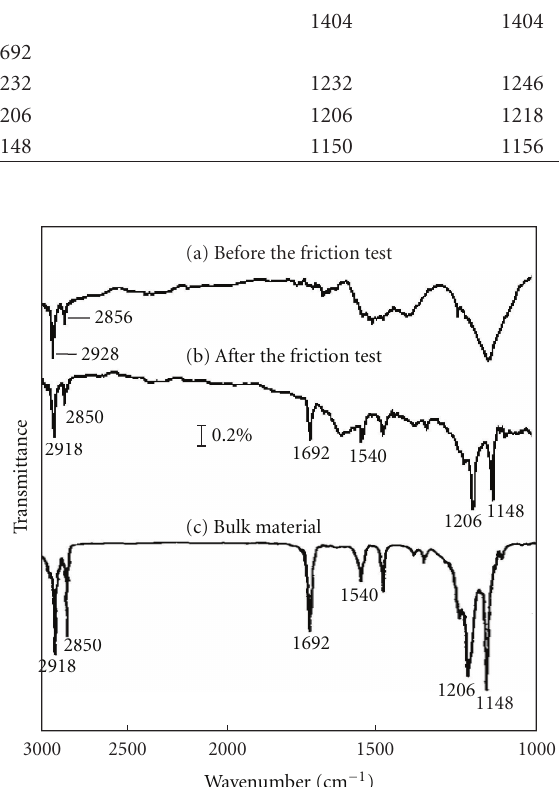
Figure 28: FTIR spectra of amide, C 7 F 15 -CONH-C 18 F 37 (Lubricant 3) (a) RAS spectra of adsorbed film (b) RAS spectra of adsorbed film after friction test (c) transmission spectrum of bulk